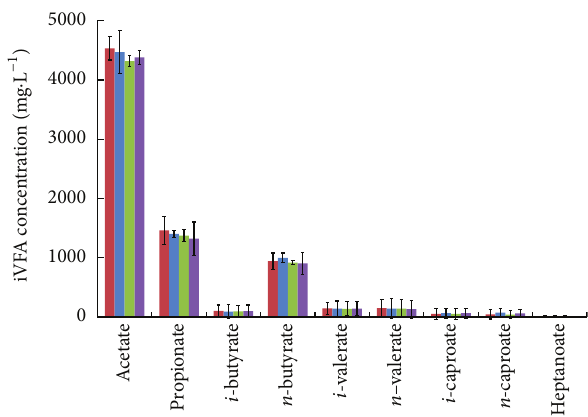
Figure 3: Postinoculation concentration of individual volatile fatty acids. Concentration of individual volatile fatty acid species = red colored bar; after inoculation with dairy manure; 𝑅 control- 1 = bluecoloredbar; 𝑅 = greencoloredbar; 𝑅 = violet 𝑅 control- 2 mixer recycle colored